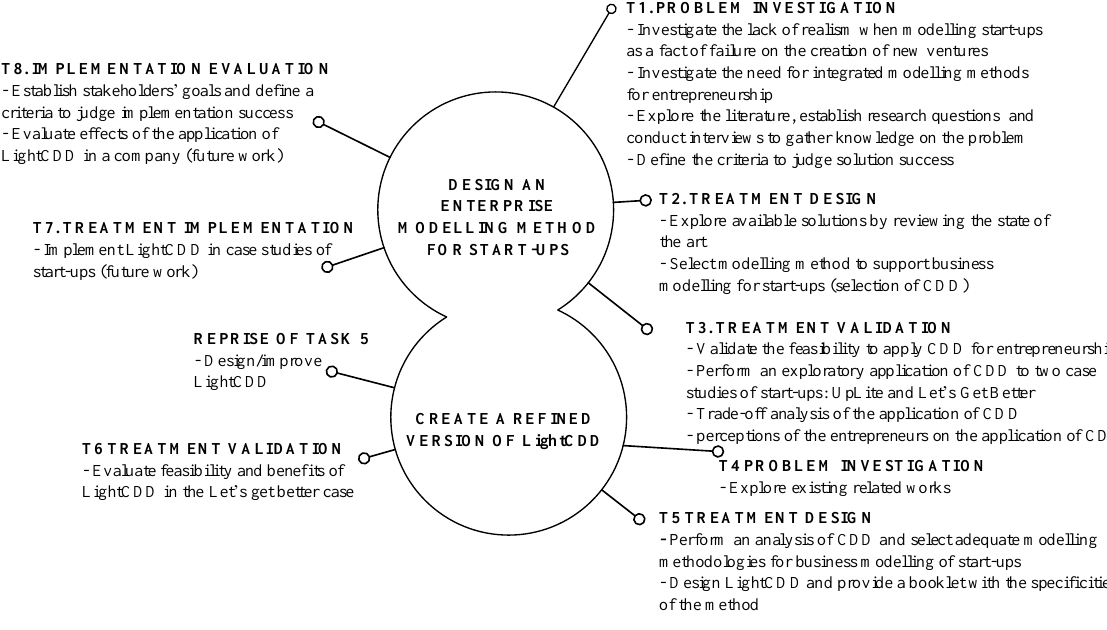
Figure 2. Overview of the research